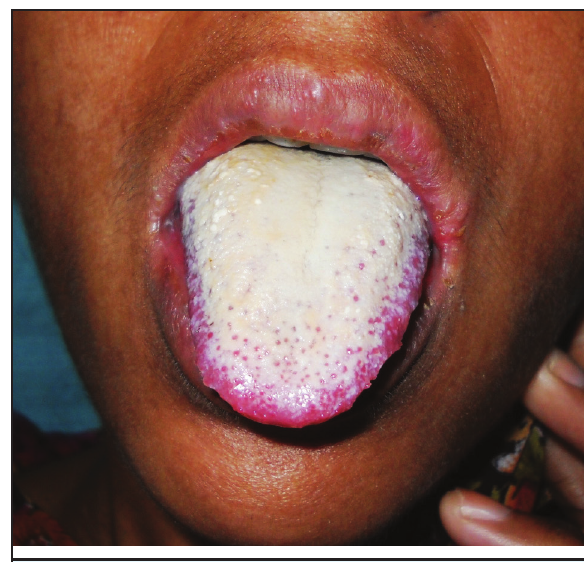
Figure 1. This 27-year-old woman presented with extensive oral candidiasis involving her tongue giving it a coated appearance. There is also angular cheilitis on the left side.